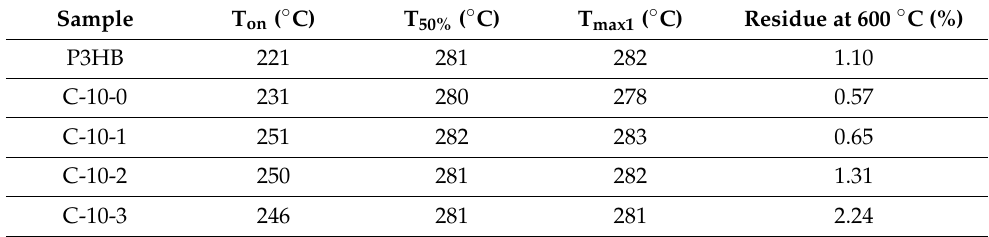
Table 2. The selected characteristic values of the TG and DTG curves of poly(3-hydroxybutyrate) (P3HB) and nanobiocomposites based on P3HB, polyurethane (PU400), and Cloisite ® 30B recorded at a heating rate of 5 °C/min in a nitrogen atmosphere (designated as C-10-1, C-10-2, and C-10-3, respectively).